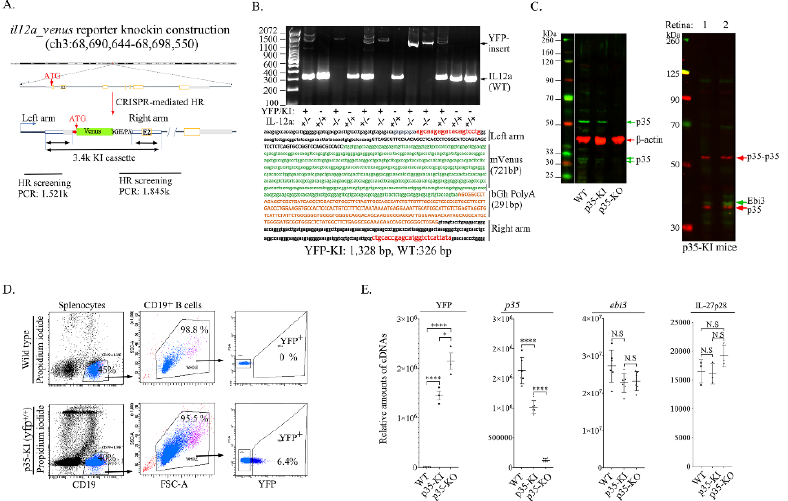
Figure 1. Generation and characterization of IL-35 reporter mouse strain. ( A ) Schematic of the DNA and cDNA constructs used to genetically engineer the il-12a-venus yellow fluorescent protein (yfp) knock-in reporter mouse by CRISPR/Cas9-mediated homologous recombination at the C57BL/6J il-12a locus. ATG in exon 1 indicates integration site of the guide RNA (gRNA), which is 5 ′ proximal to the Venus cDNA and bGHPA (bovine growth hormone polyadenylation signal), as shown. The complete 3814 bp il-12a-yfp knock-in allele cassette was inserted between the left and right homologous arms, and PCR primers used to validate homologous recombination (HR) are shown. ( B ) Tail DNA genotype analysis showing PCR products used to identify mice with successful homologous recombination. Wild-type control mice (WT) express the IL-12p35 protein but not yfp ( il12 +/+ ); mice expressing yfp from both chromosomes ( il12a yfp/yfp ) do not express IL-12p35 ( il12 − / − ) and are henceforth referred to as IL-12p35 knock-KO (p35-KO); mice expressing yfp only from